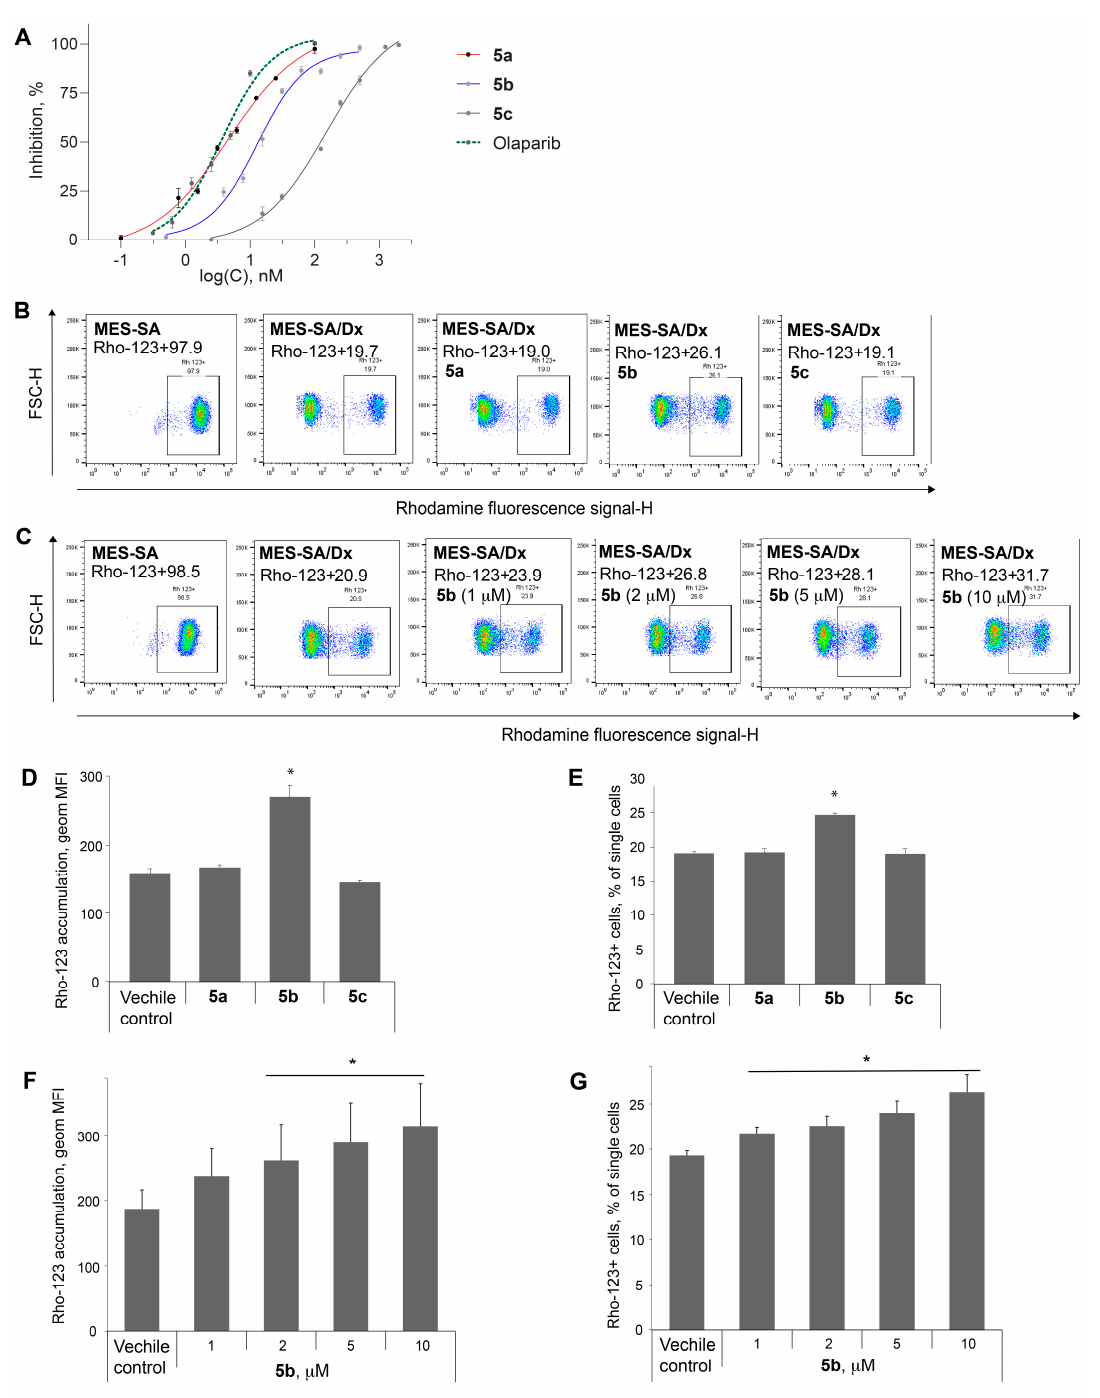
Figure 2. ( A ) Inhibition of PARP1 in the presence of 5a – c ; ( B ) representative plots of Rhodamine– 123 accumulation determined by flow cytometry in the presence of 5a – c (10 μ M); ( C ) representative plots of Rhodamine–123 accumulation determined by flow cytometry in the presence of 5b (dose dependent from 1 to 10 µ M); ( D ) intracellular Rho–123 fluorescence intensity after treat- ment with 5a – c ; ( E ) the proportion of cells that accumulated Rhodamine-123 (Rho–123 positive cells) after treatment with 5a – c (10 µ M); ( F ) intracellular Rho–123 intensity after treatment with 5b (dose–dependence from 1 to 10 µ M); ( G ) the proportion of cells that accumulated Rho-123 after treatment with 5b (dose–dependence from 1 to 10 µ M); significant difference (* p < 0.05) compared with MES–SA/Dx–5